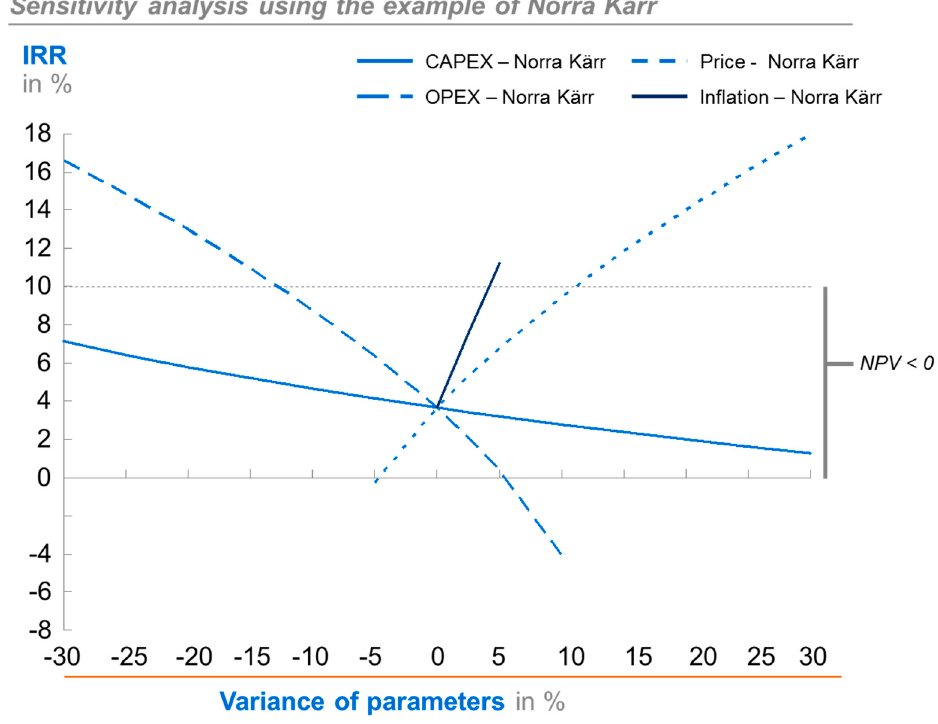
Figure 9. Sensitivity analyses for the parameters of Capex, Opex, and the basket price of the project Norra Kärr.